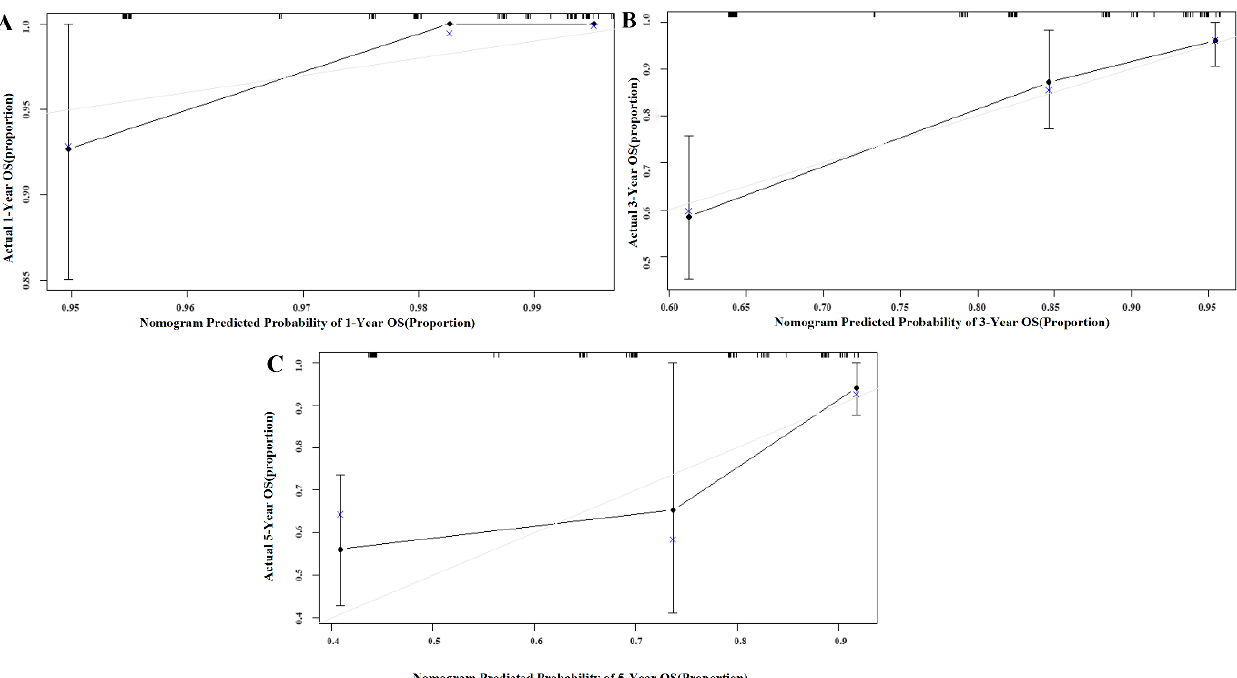
Figure 3. Calibration curve of the nomogram in the validation cohort, with the x -axis representing the actual survival estimated by the nomogram and the y -axis representing the observed survival calculated by the Kaplan-Meier method. ( A ) 1-year OS in the validation cohort. ( B ) 3-year survival OS in the validation cohort. ( C ) 5-year survival OS in the validation cohort. Table 3. C-index of the nomogram and TNM stage in the primary cohort and validation cohort.